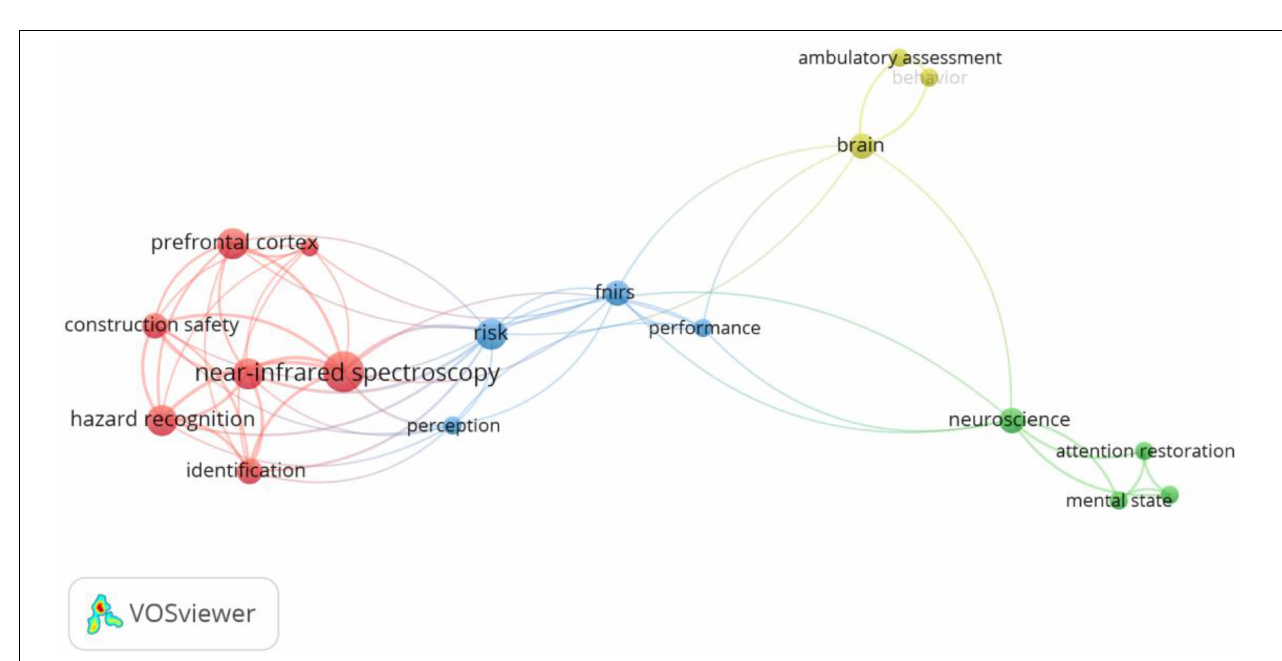
FIGURE 11 | Keywords co-occurrence network of fMRI.